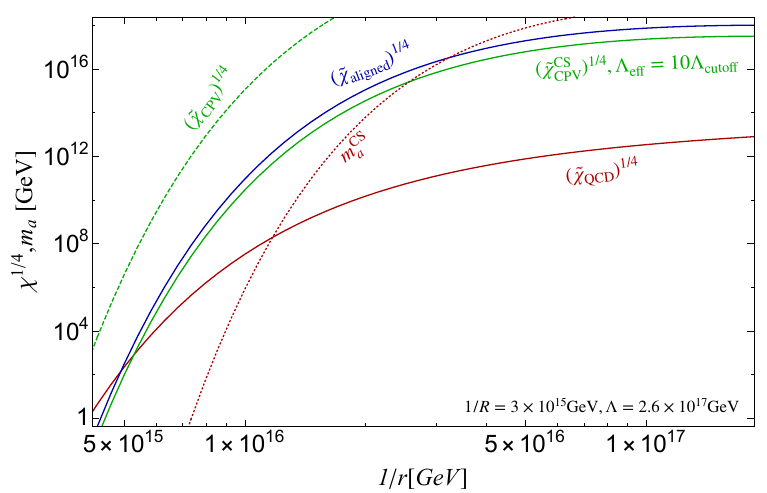
Figure 6 . Various contributions and axion mass (with chiral suppressions) with a dynamical radion field, r . We fix 1 /R = 3 × 10 15 GeV , Λ = Λ cutoff = 1 / 10Λ eff and Λ 3 R = M 2